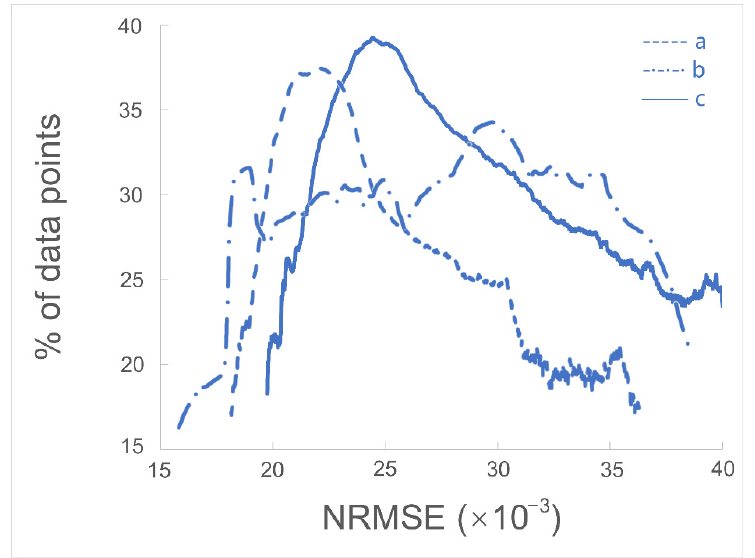
Figure 7. Percentage distributions of NRMSE (×10 − 3 ) in (a) West Pacific, (b) Southern Ocean, and (c) East Pacific. (c) East